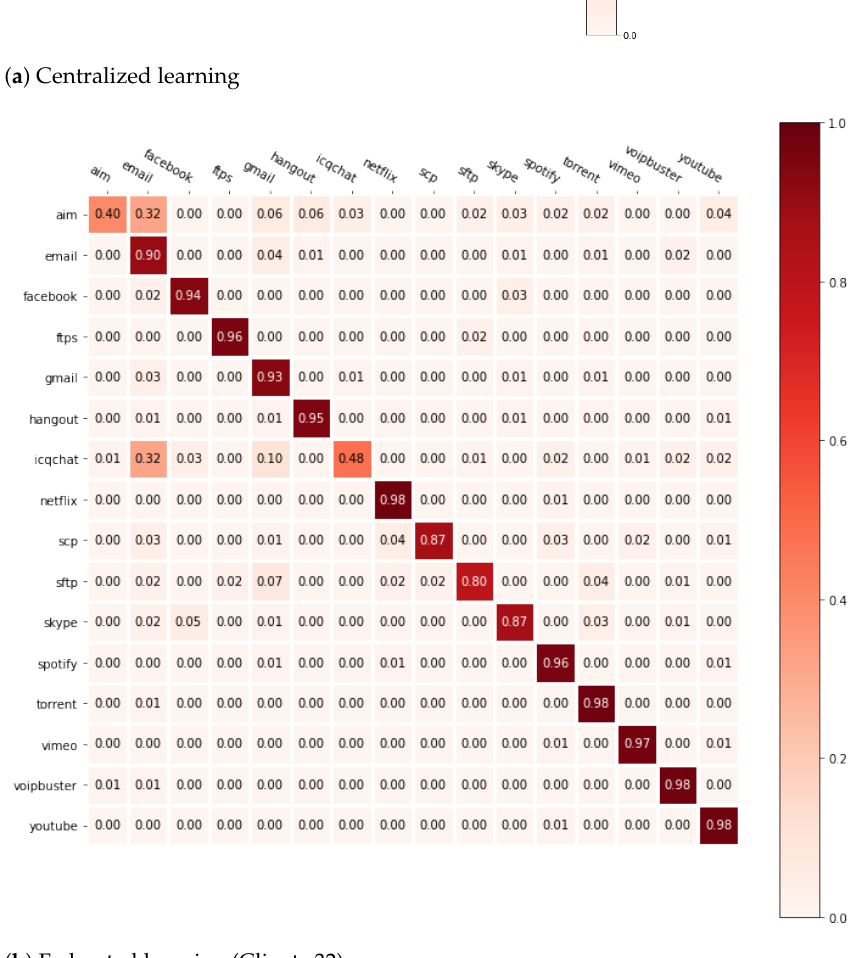
Figure 8. A confusion matrix of centralized learning and federated